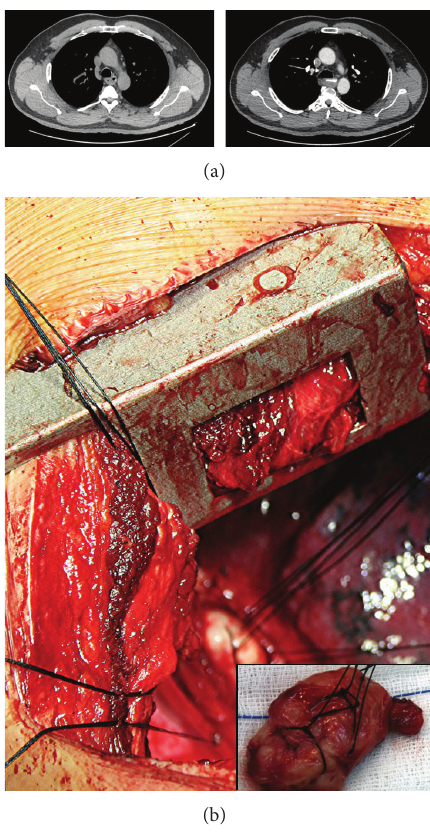
Figure 1: (a) CT scan of the chest, showing a well-circumscribed 5cm submucosal esophageal mass. (b) Intraoperative view of the tumor (inset: macroscopic view of the resected specimen).